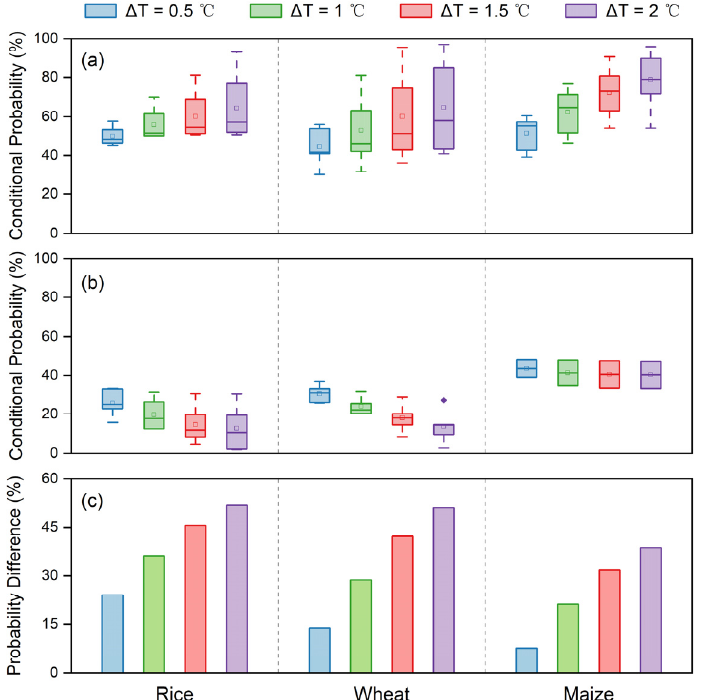
Figure 6. Conditional probability distribution of yield variation ( ∆ Yield) given four warming condi- tions ( ∆ T GS = 0.5, 1, 1.5, and 2 ◦ C) for provinces where yield and temperature were ( a ) negatively correlated and ( b ) positively correlated, respectively. The mean difference of conditional probability between ( a ) and ( b ) is shown in ( c ).